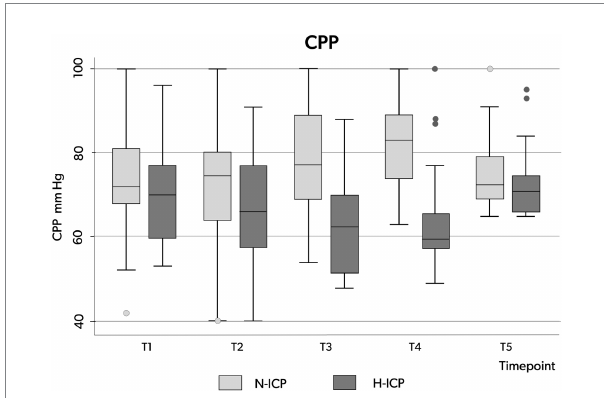
FIGURE 4 Box plots illustrating the distribution of CPP values (minimum value, first quartile, median, third quartile, and maximum value) at the five time points in patients presenting with N-ICP (light gray boxes) and